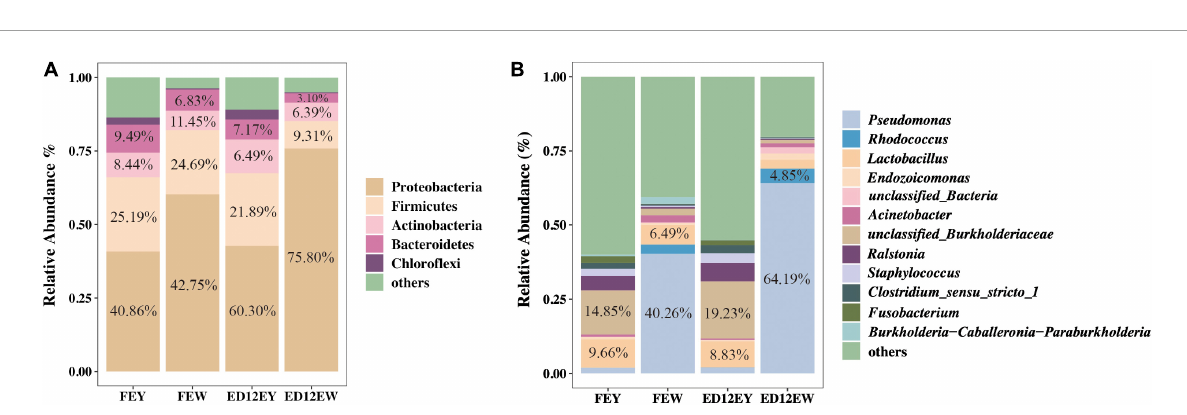
FIGURE3 Microbiota composition in egg yolk and egg white for fresh and incubated eggs. (A) The relative abundance of dominant microbial phyla in the egg yolks and whites at different periods. (B) The relative abundance of 12 genera in the egg yolks and whites at different periods. 12 genera were comprised of the top five genera with the most relative abundance without overlap in each